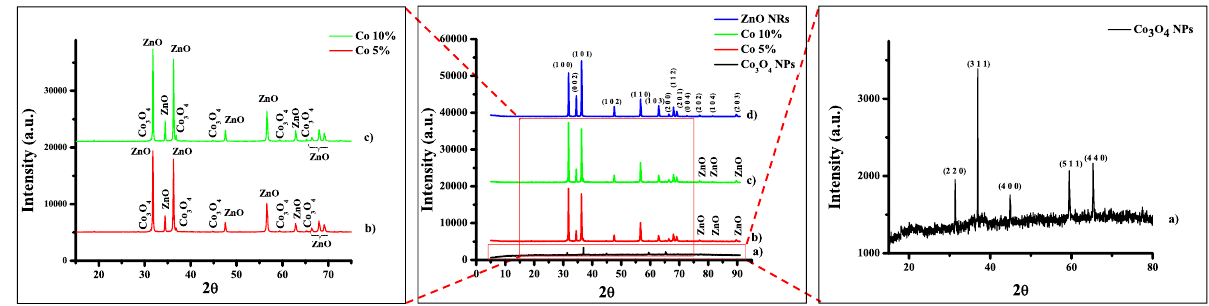
Figure 2. XRD pattern of ( a ) Co 3 O 4 NPs, ( b ) Co 5% nanocomposite, ( c ) Co 10% nanocomposite and ( d ) ZnO NRs.